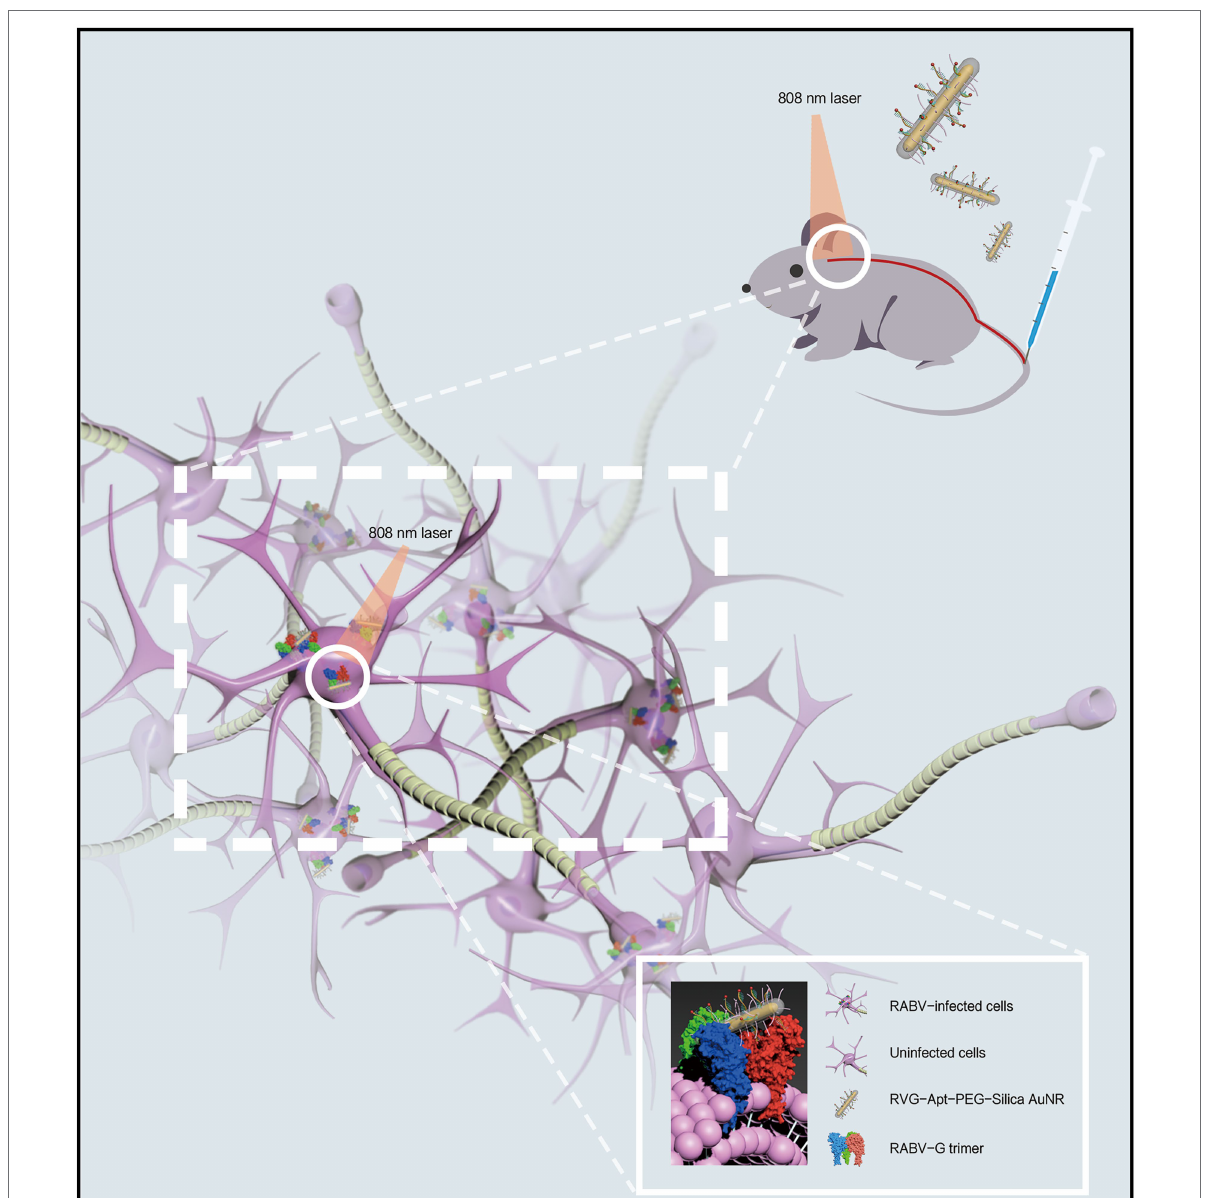
FIGURE 3 | Schematic diagram of CNS delivery and viral-targeting photothermal therapy by a rabies virus glycopeptide (RVG) peptide-functionalized